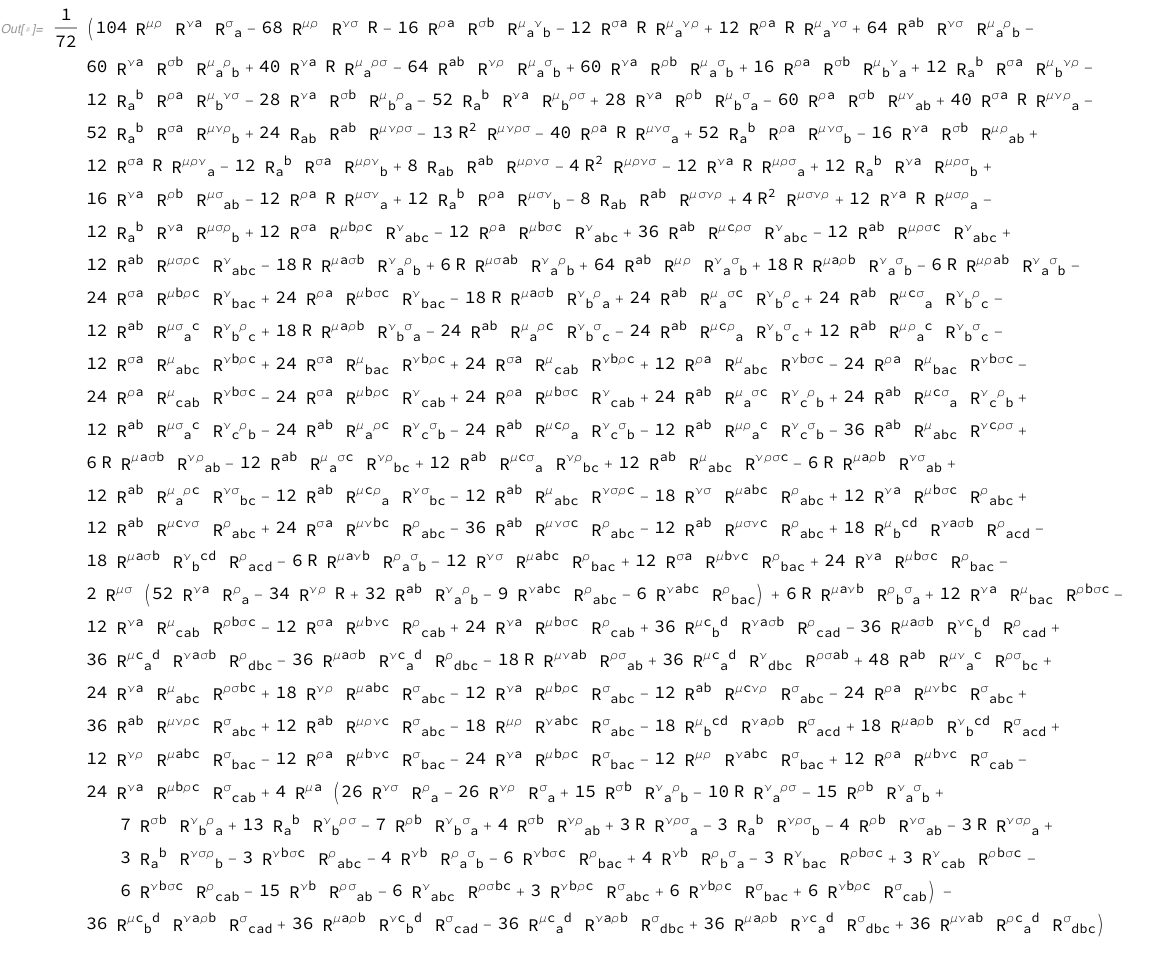
Figure 13. The closed form of dW/dR µνρσ . Internal indices are given Latin